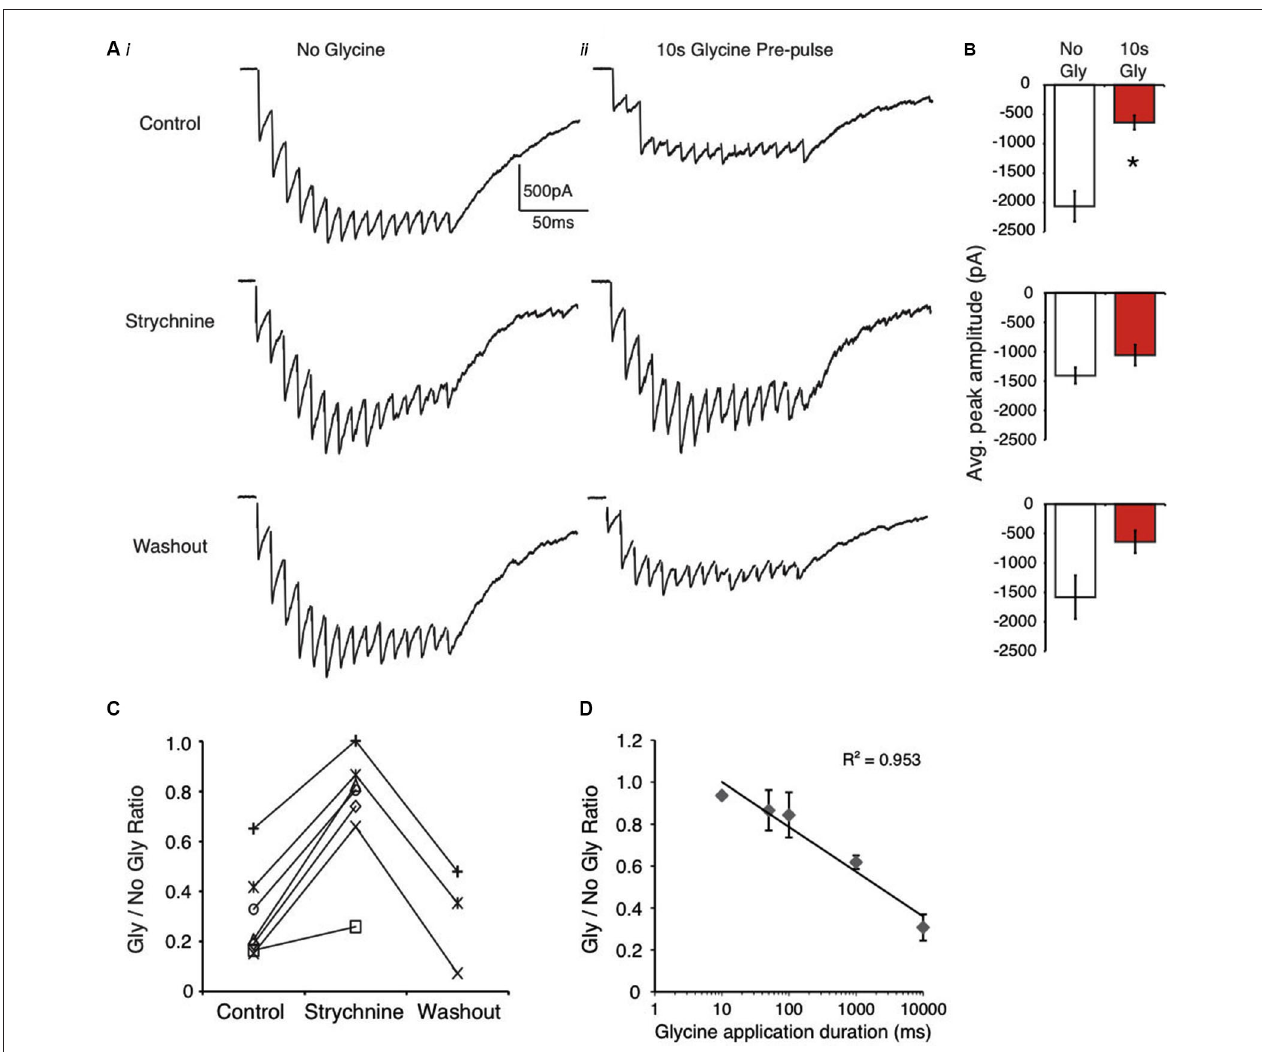
significant difference, p < 0.01). (C) Ratio of peak amplitude between Gly/no Gly shows an increased ratio value (less suppression) during GlyR block (strychnine). (D) Plot illustrates that IPSC suppression increases with increasing glycine application duration ( R 2 = 0.953, p < 0.001, Pearson’s